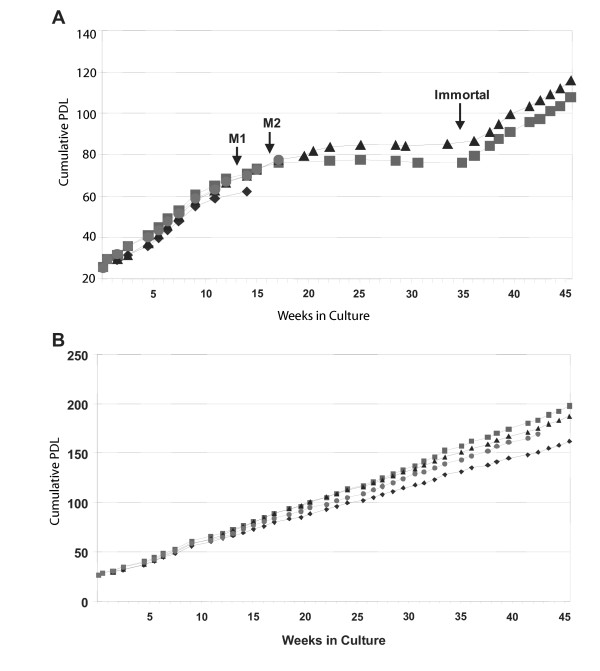
Growth curves of transduced fibroblasts. The x-axis is the number of weeks of continuous culture. The y-axis represents the number of population doublings the cultures had accumulated. A. (◆) F1-HIT+LXIN; (■) F1-HIT+p53-A143V; (▲) F1-HIT+p53-H179Q; F1-HIT+E6. The empty vector control (●) F1-HIT+LXIN cell line underwent senescence at PDL 61 while the cells with defective p53 function continued to divide for an additional 10 – 20 population doublings. At this point cell death equaled cell division, resulting in no net gain of cell number over time. During the approximate 16-week duration of this phase the E6-expressing cells died. B. Continuous growth of hTERT-expressing lines. (◆) F1-hTERT+LXIN; (■) F1-hTERT+p53-A143V; (●) F1-hTERT+p53-H179Q; F1-hTERT+E6.